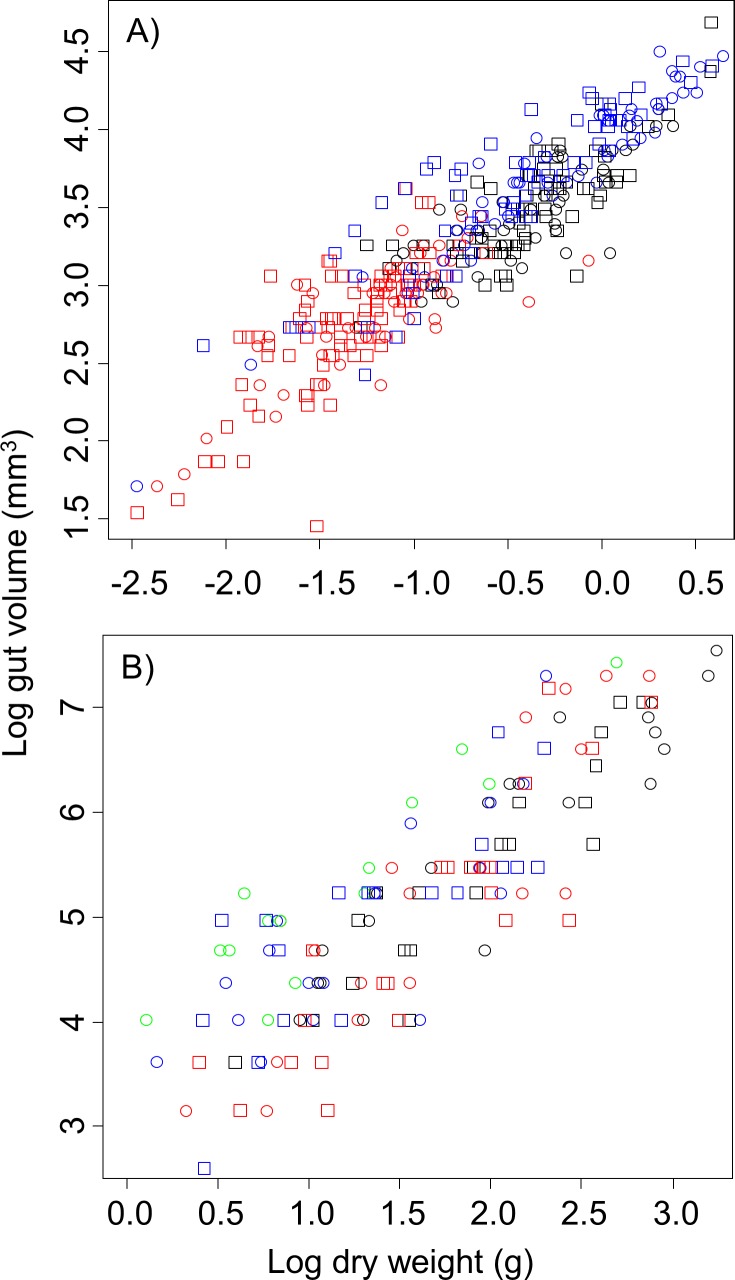
Log stomach volume (mm3) as a function of log dry body mass (g) for A. pisonii (A), and O. quadrata (B). For both, circles are males, squares are females. For A. pisonii, black are from a dock habitat, red are from a saltmarsh habitat, and blue are from a mangrove habitat. For O. quadrata, disturbance levels of beaches are pristine (black), moderately impacted by humans (red), heavily impacted by humans (blue), heavily impacted by humans and vehicles (green).